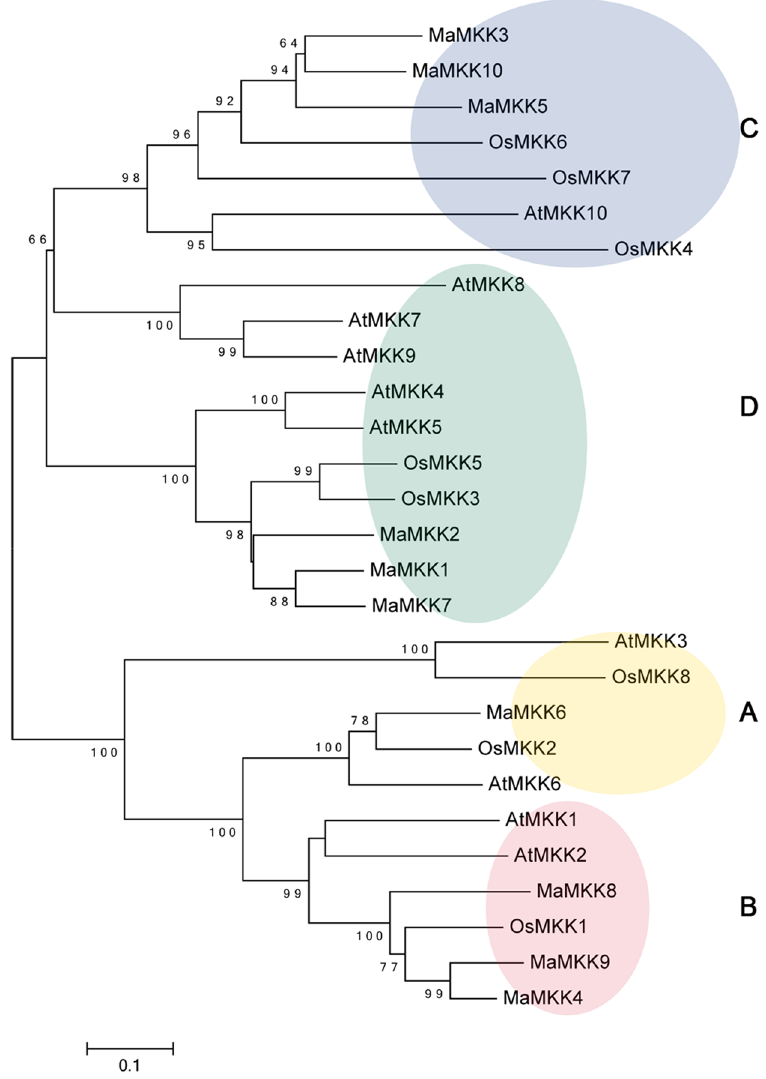
Figure 1. Phylogenetic analysis of MAPKKs from banana, rice and Arabidopsis. The Neighbor-joining (NJ) tree was constructed using ClustalX 2.0 and MEGA 5.0 software with 1000 bootstrap